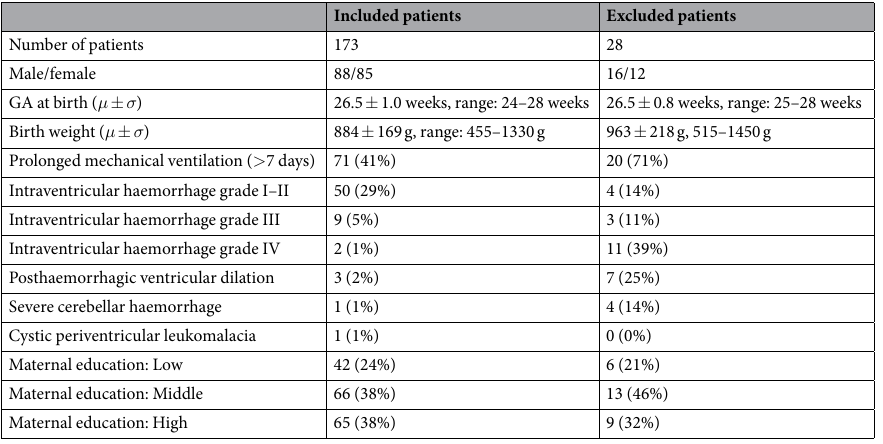
Table 1. Patient characteristics and the number of patients with brain injury included and excluded in this